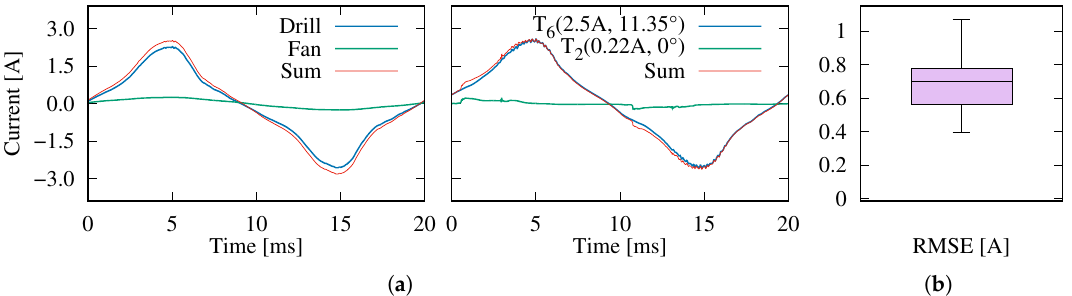
Figure 12. Results of the greedy optimization approach to approximate the superimposed current waveforms of a drill and a fan appliance by means of parametric templates. ( a ) Aggregation of input data from two electrical appliances as well as a visualization of their reconstruction from templates; ( b ) Distribution of RMSE values.